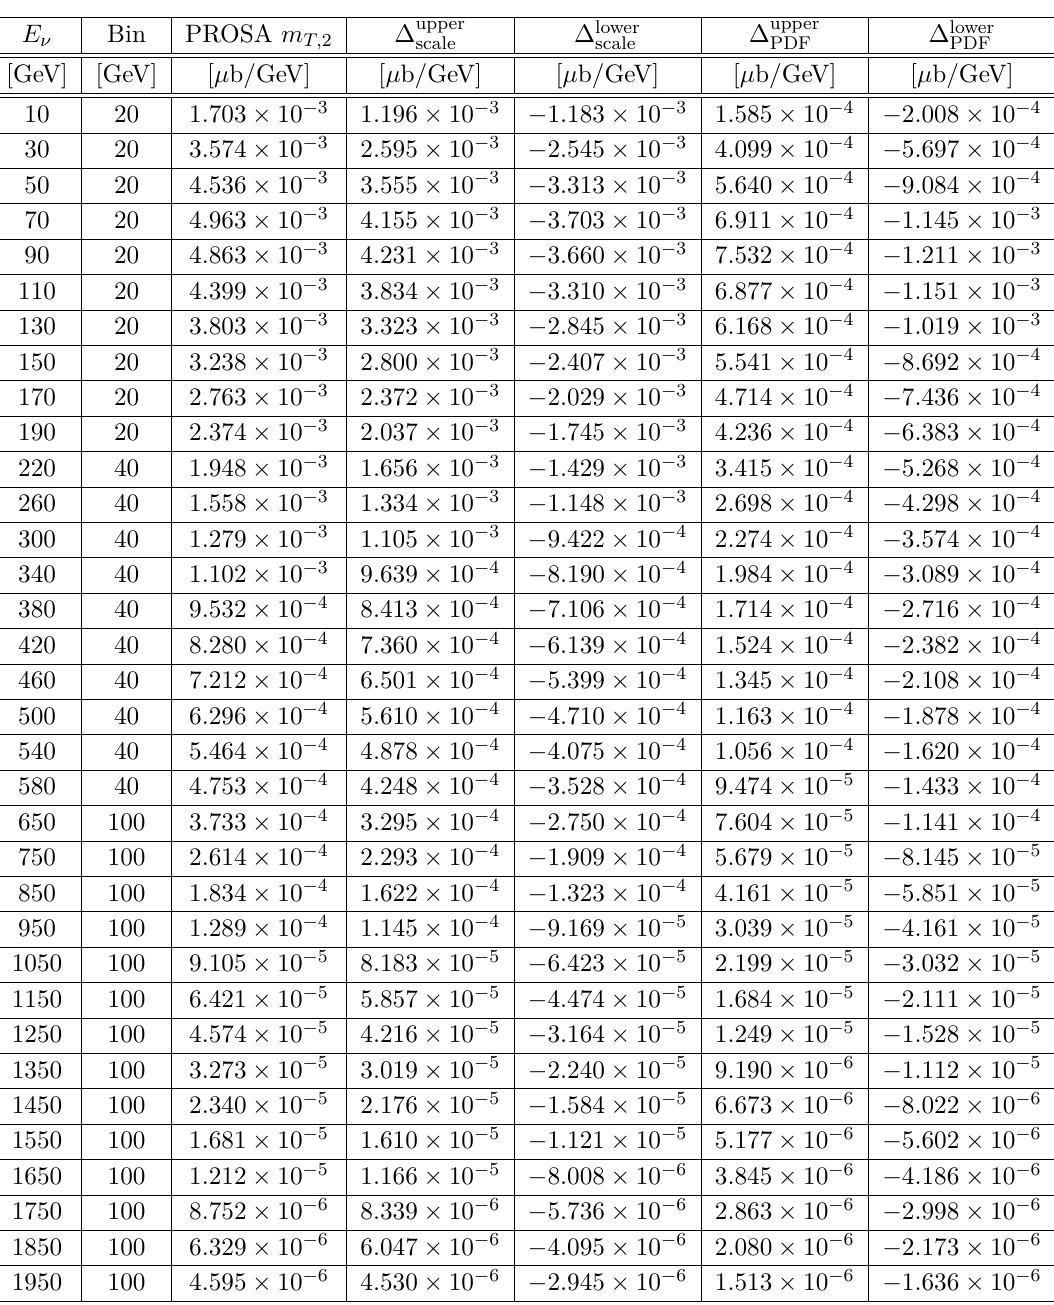
√ s = 14 TeV and η ν > 6 . 9 . The